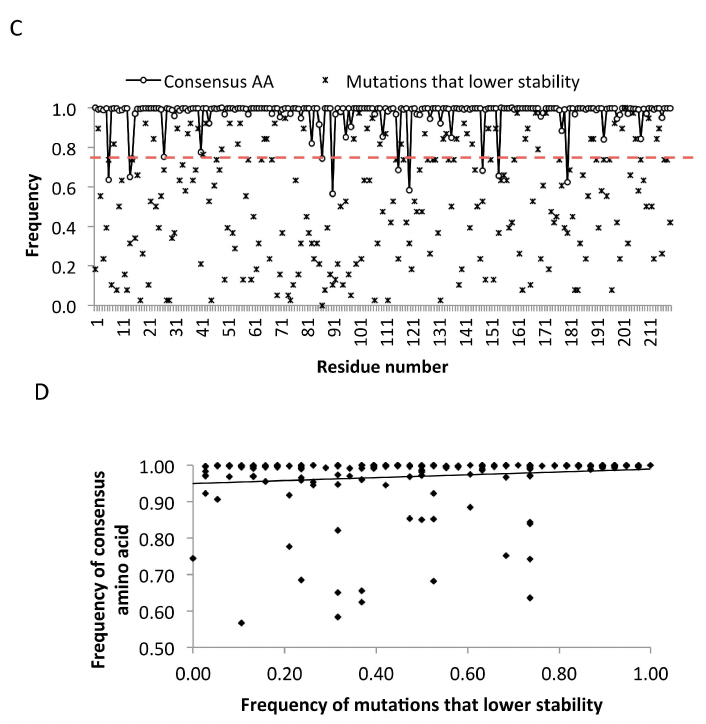
Figure 7. HIV-1 capsid (CA) sites prone to destabilizing mutations. ( A , B ) The amino-terminal domain (NTD) is shown in cyan and the carboxy-terminal domain (CTDd) is in yellow with the sites prone to destabilizing mutations highlighted in blue and orange; ( A , B ) side-view of three CA chains and two additional CTD from a hexamer of the hexamer of hexamer (HOH); ( B ) showing the solvent accessible surfaces; and ( C ) the database frequency of the consensus amino acid (open circle) and the frequency of mutations that lower stability (“ ˆ ”) at each CA residue. The dash line shows the frequency of 0.75. ( D ) There is no linear relationship between sequence conservation and the frequency of mutations that lower stability. Each dot represents a